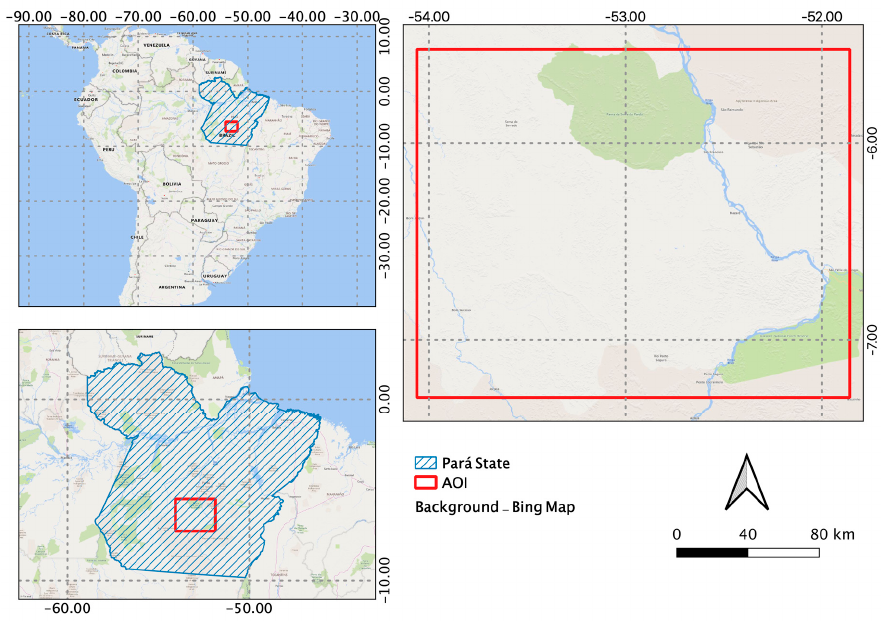
Figure 1. Location of the area of interest.